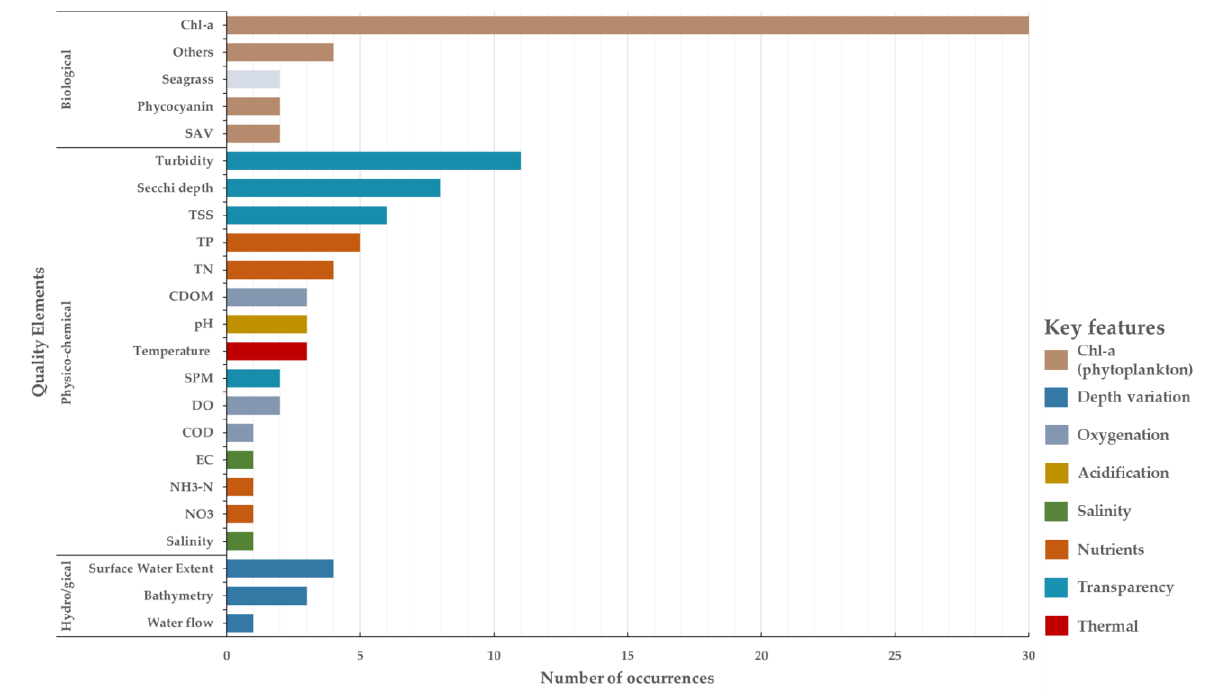
Figure 5. Overview of the QEs examined by the studies included in this review. Others are mostly biological water quality indicators and indices (e.g., DIN, DIP, macroalgal, NDWI, etc.). Biological QEs